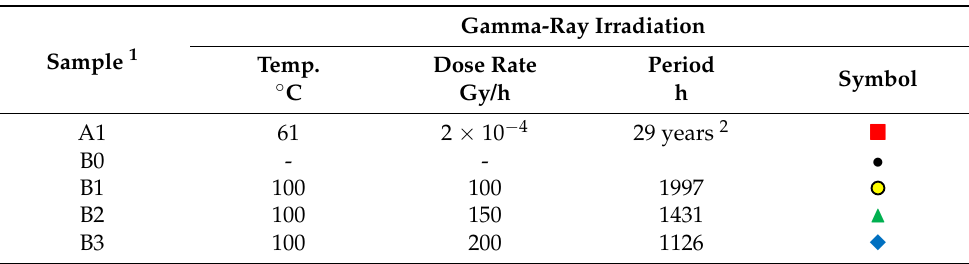
Table 1. Cables removed from the nuclear power plant A1, pristine unaged B0, and equivalently aged artificially B1, B2, and B3.